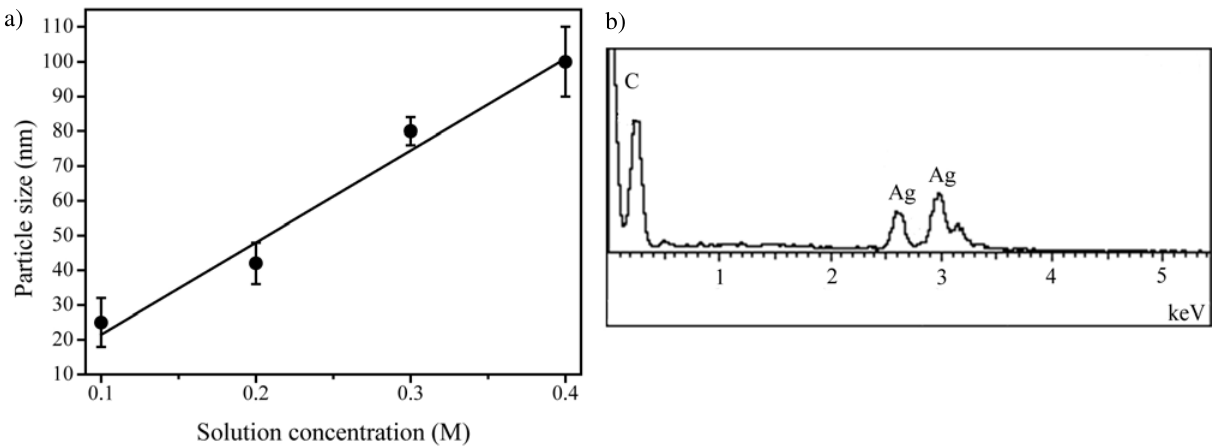
Fig. 3. a) Dependence of the Ag NPs’average size on the concentration of the used ammonia-alcoholic solution, b) EDX-spectrum of NPs obtained from ammonia-alcoholic